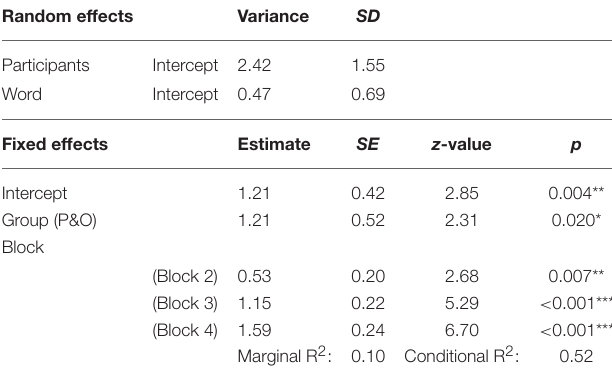
TABLE 1 | Results of mixed-model analysis of the effects of group (Phonology, Phonology & Orthography) and learning block (1, 2, 3, 4) on number of pseudowords learned.